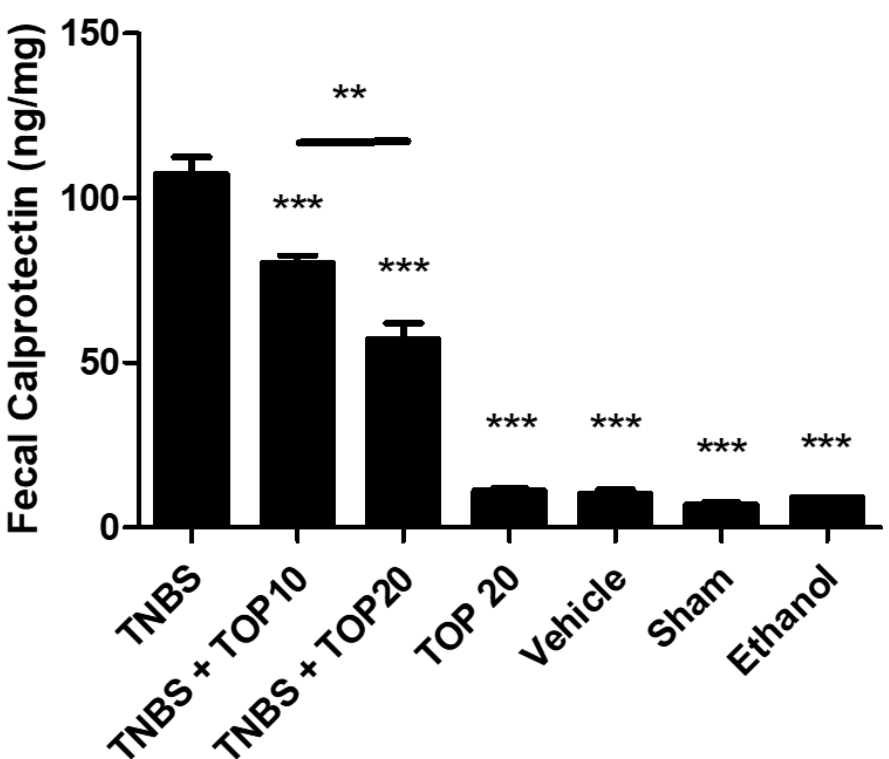
TOP20 (38.78 ± 1.92 pg/mL), ethanol (38.60 ± 5.10 pg/mL), vehicle (38.08 ± 1.99 pg/mL), Figure 4. Effect of topiramate treatment on fecal calprotectin concentration. Legend: one-way ANOVA and Tukey’s post-hoc test, ** p < 0.001 between groups, *** p < 0.0001 compared with the TNBS group.